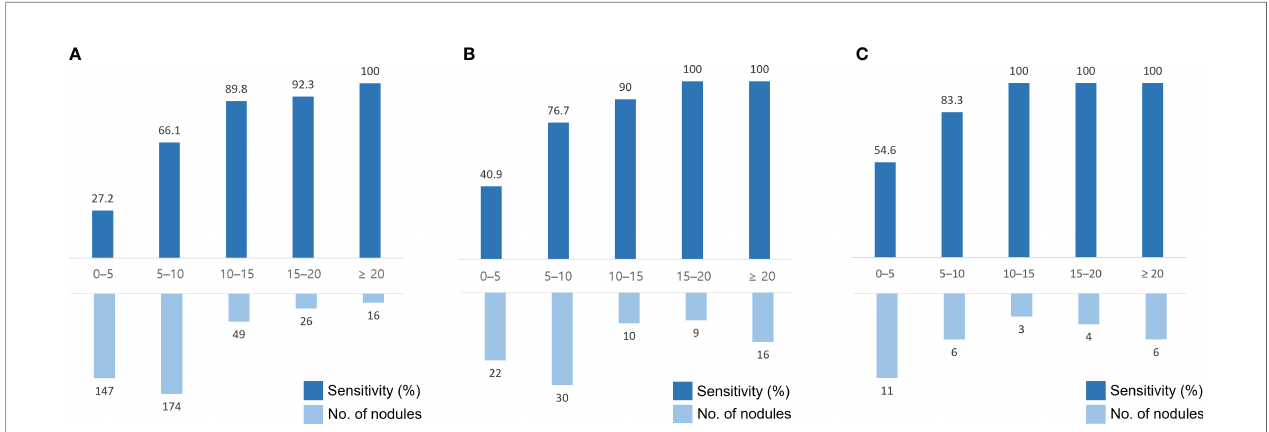
FIGURE 3 | Sensitivity and number of brain metastases (BMs) in different nodule sizes in the temporal test set #1 (A) , the geographic test set (B) , and the temporal test set #2 (C) . The x-axis indicates the size of the nodules